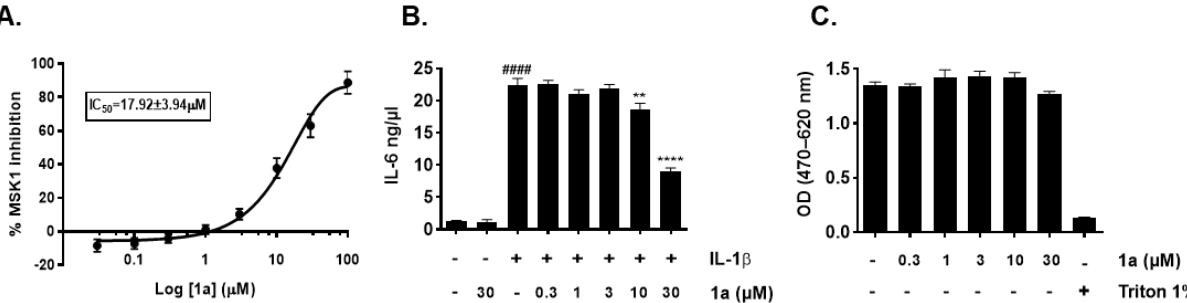
Figure 3. Enzymatic and in vitro characterization of the hit compound 1a . ( A ) Enzymatic inhibition of MSK1 (Kinase-Glo ® , Promega). Bullets are means and bars are SD ( n = 4). ( B ) Inhibition IL-6 production (ELISA) after in vitro inflammatory stimulation of human primary pulmonary fibroblasts by IL- 1β. Blocks are means and bars are SEM ( n = 4). ** p < 0.01, **** p < 0.0001 compared to the control IL- 1β group. #### p < 0.0001 compared to the non-stimulated control. ( C ) Cell toxicity evaluation in human pulmonary fibroblasts (WST1 assay) after 24 h of incubation. Blocks are means and bars are SEM ( n = 4).